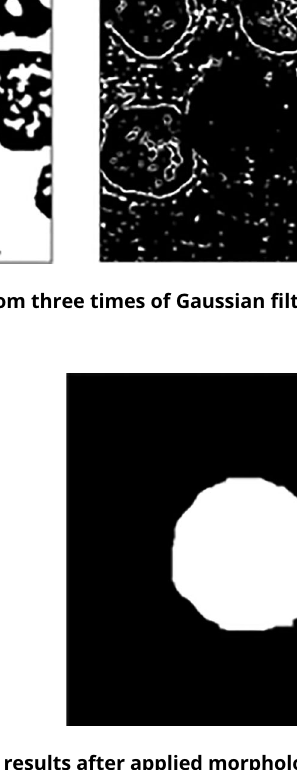
Figure 5. Final segmentation results after applied morphological